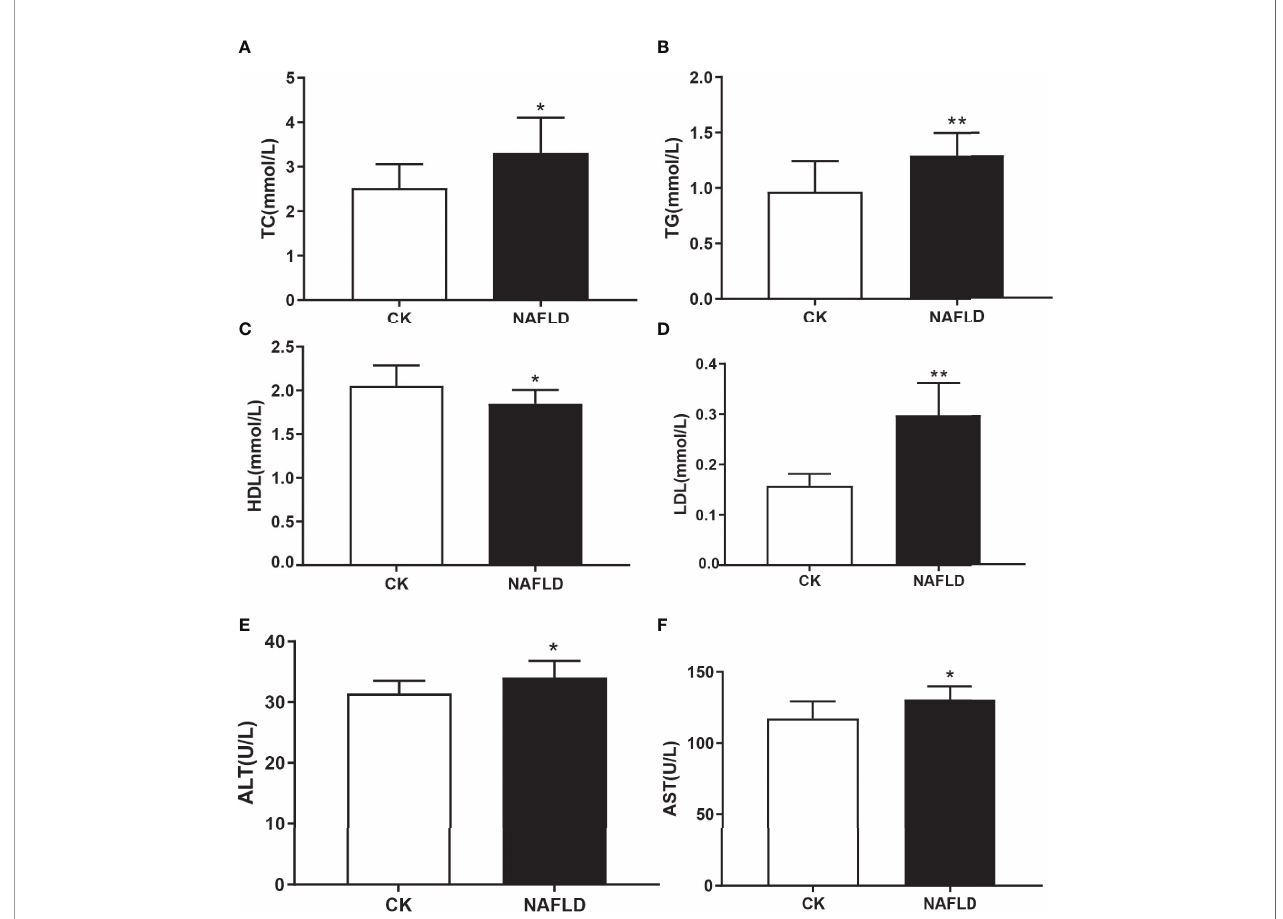
FIGURE 2 | Serum lipid and liver function in Control and NAFLD mice. (A-F) Total cholesterol (TC), triglycerides (TG), high density lipoprotein (HDL), low density lipoprotein (LDL), aspartate aminotransferase-AST (E) and alanine aminotransferase (ALT) were signi fi cantly elevated in NAFLD mice. “ * ” indicated p-value < 0.05, “ ** ” indicated p-value < 0.01 (Students t